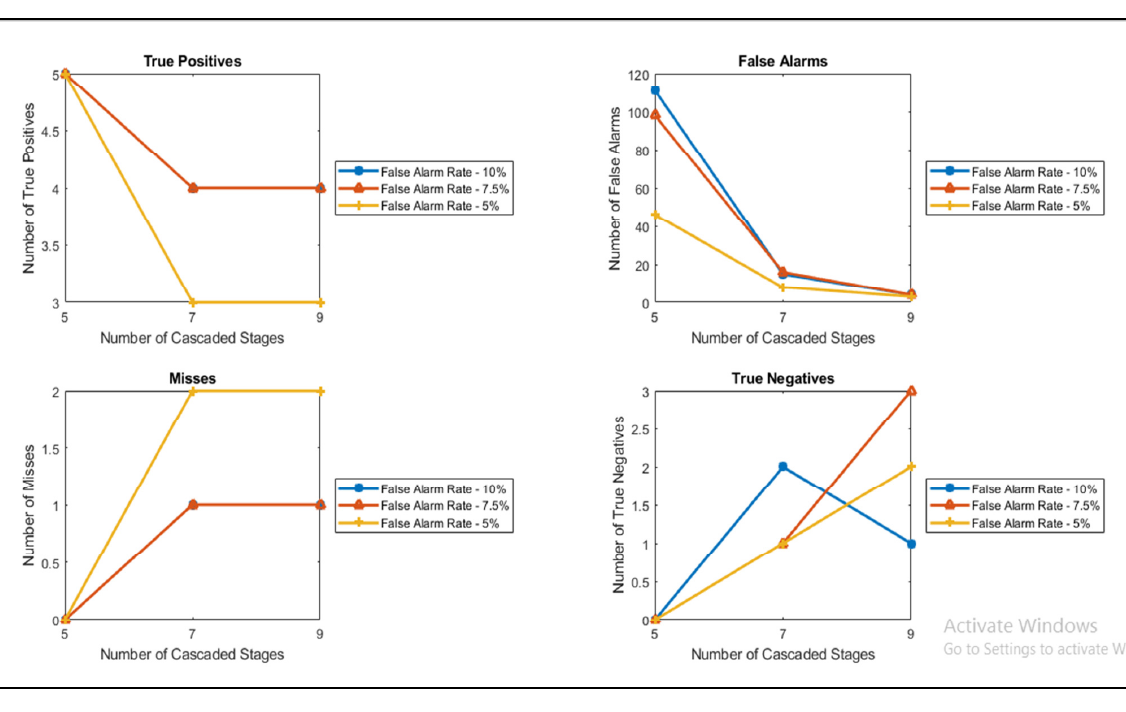
Fig. 9. Results with different Number of Cascaded Stage.